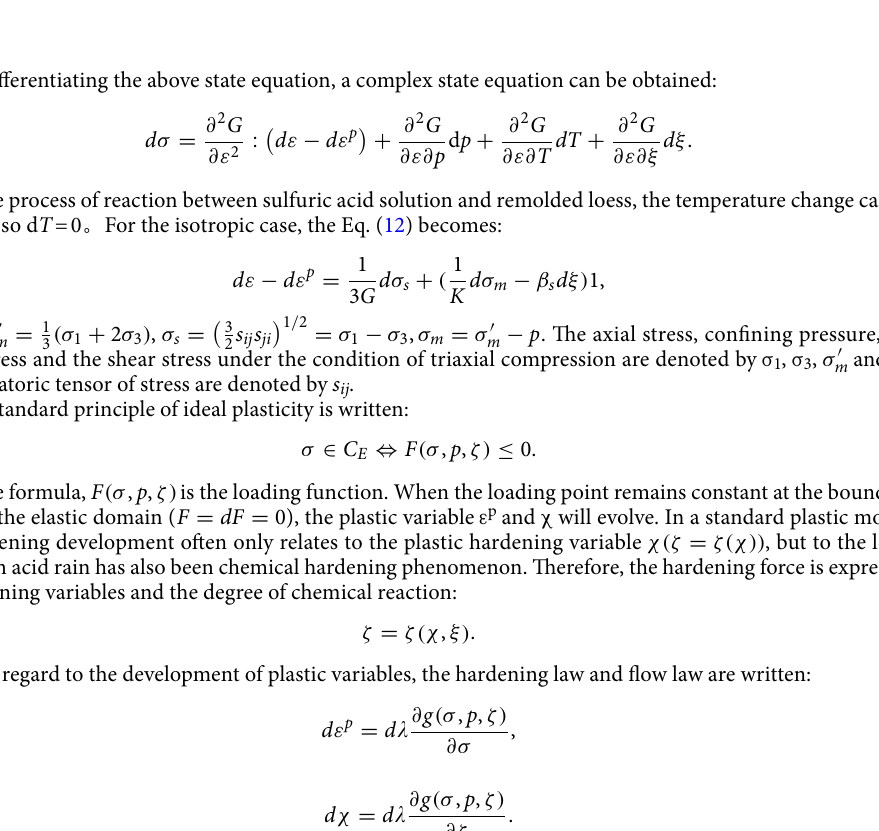
Table 2. The number and percentage of soil pores at different pH